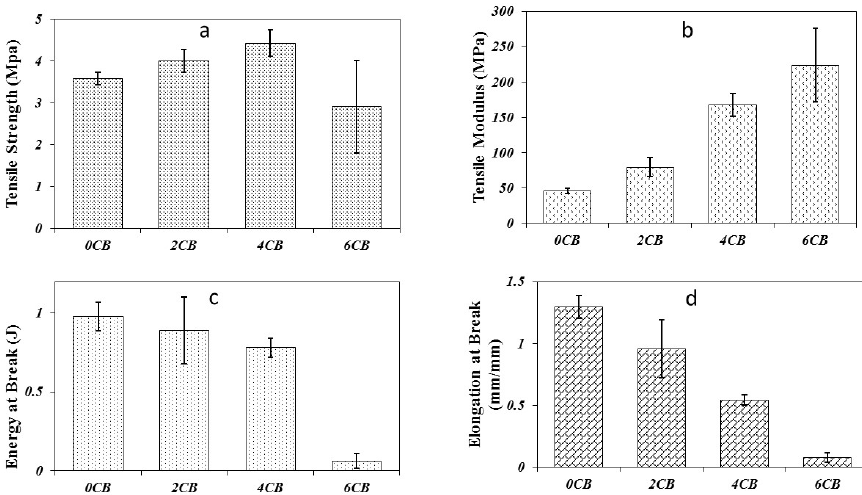
Figure 1. Tensile properties of gluten/CB biocomposites, ( a ) Tensile strength, ( b ) Tensile modulus, ( c ) Energy at Break, and ( d ) Elongation at break.